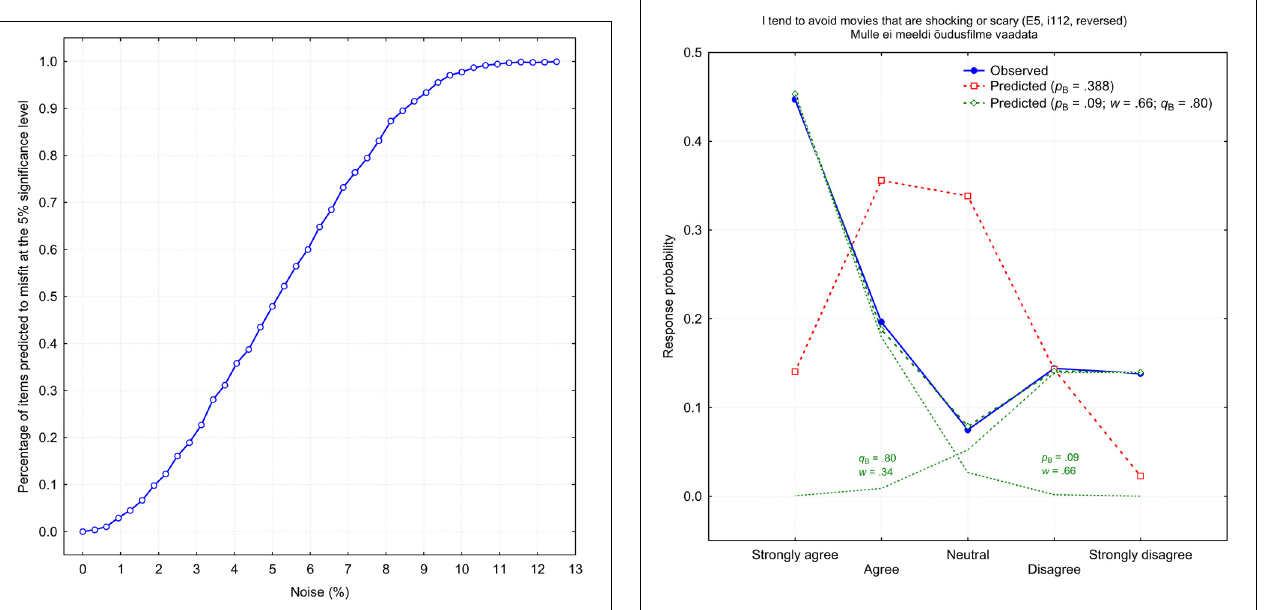
FIGURE 4 | Proportion of items predicted to misfit at the 5% significance level on χ 2 -statistics as a function of random noise percentage.